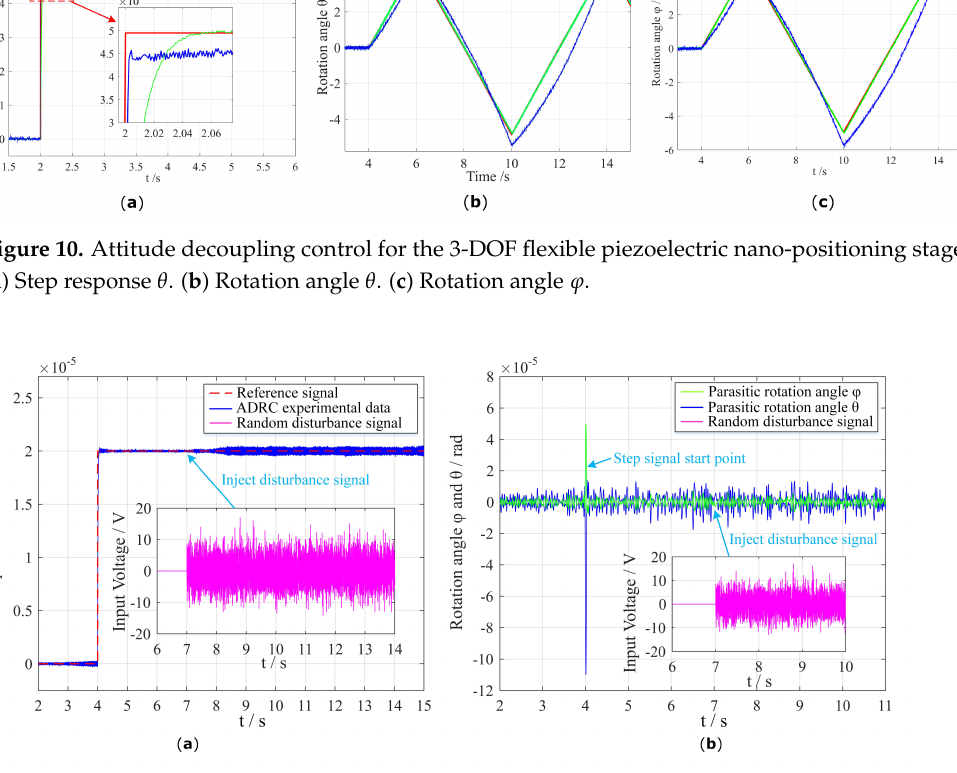
Figure 11. Three output closed-loop testing signals of PZT nano-positioning stages under step and disturbance signals. ( a ) Displacement Z . ( b ) Parasitic rotation angle ϕ and θ .